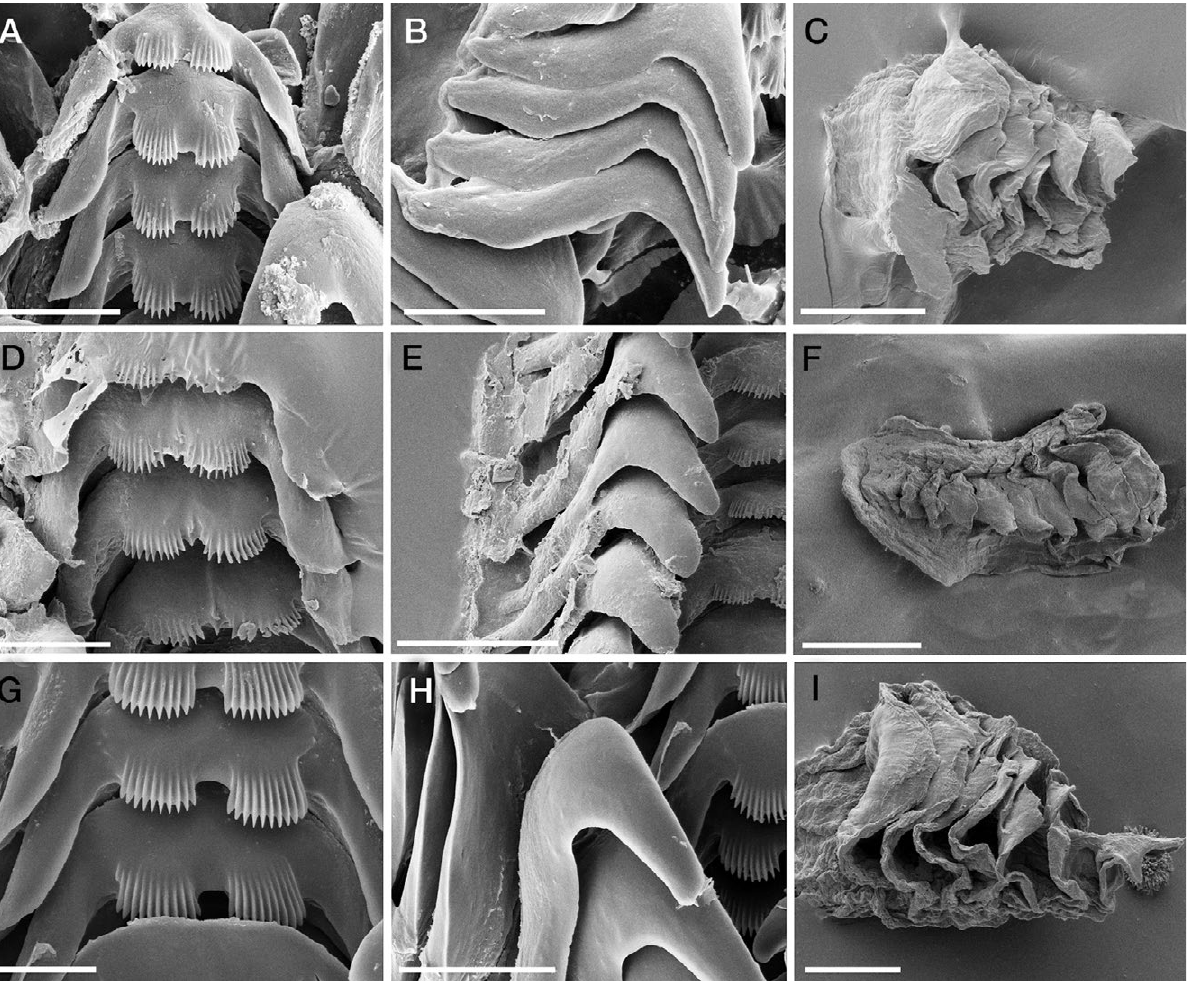
Fig. 5. – Scanning electron micrographs of jaw and radula of Runcina species. A, B, C, R. brenkoae (MNCN 15.05/88086, MNCN 15.05/88088): A, radular teeth (MNCN 15.05/88088); B, lateral teeth (MNCN 15.05/88086); C, Gizzard plate (MNCN 15.05/88088). D, E, F, R. lusitanica n. sp. (MNCN 15.05/88093): D, radular teeth; E, lateral teeth; F, Gizzard plate. G, H, I, R. marcosi n. sp. (MNCN 15.05/88095, MNCN 15.05/88097): G, radular teeth (MNCN 15.05/88095); H, lateral teeth (MNCN 15.05/88095); I, Gizzard plate (MNCN 15.05/88097). Scale bars: A, B, E, H=10 µm; C=50 µm; D, I=20 µm; F=100 µm; G=5